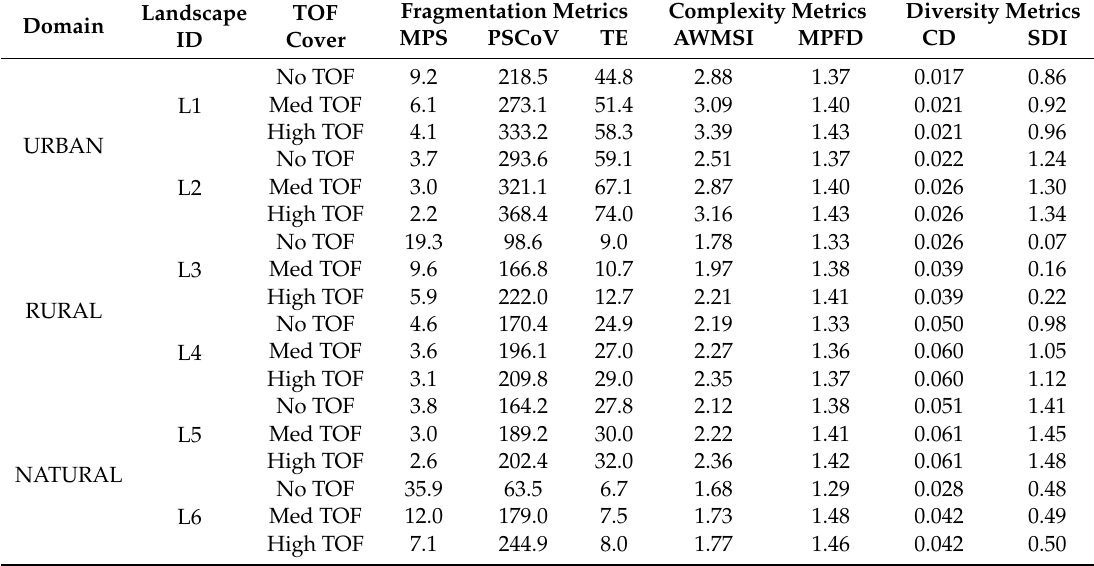
Table 2. Values of the seven landscape metrics for the 18 analyzed viewsheds. Mean patch size